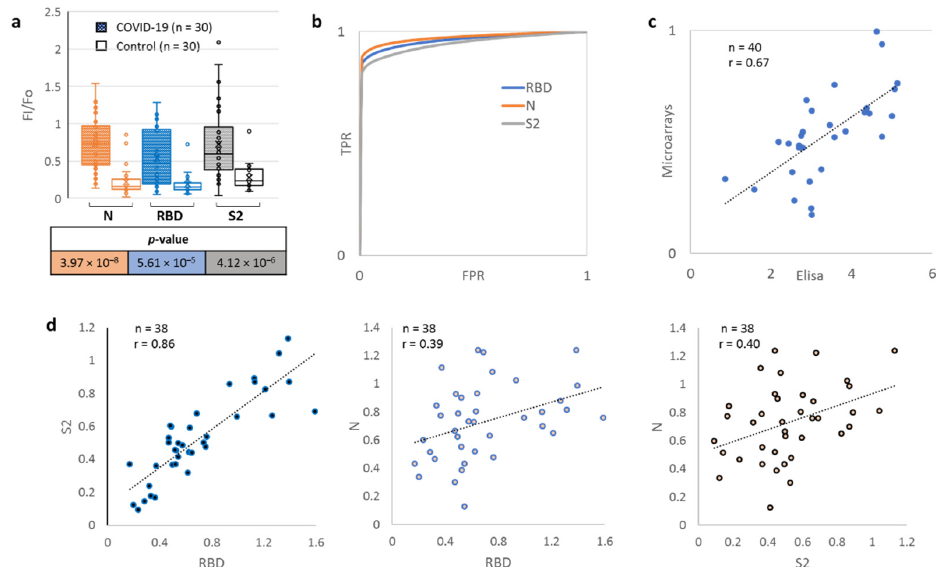
Figure 2. Microarray validation and comparison with ELISA. ( a ) Profiling responses to structural SARS-CoV-2 proteins using protein microarrays; ( b ) ROC curves for N, S2 and RBD proteins; ( c ) Correlation between microarray-based and ELISA-based evaluations of RBD-recognizing Abs and ELISA data; ( d ) Correlation between RBD-, S2- and N-recognizing Abs (microarray-based data).